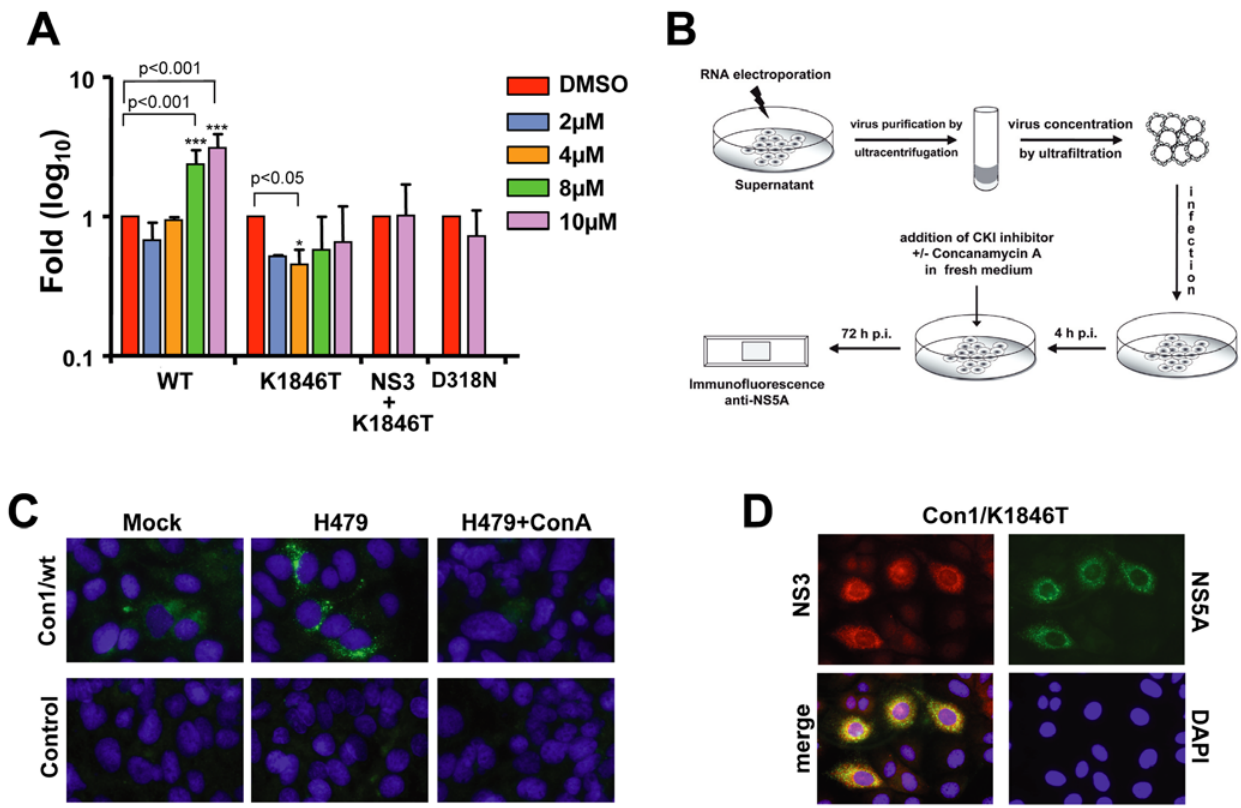
Figure 6. Invitro infectivity of Con1/wt particles released from transfected Huh7.5 cells. (A) Enhancement of HCV RNA replication by kinase inhibitor H479. Subgenomic Con1 luciferase replicons were transfected into Huh7.5 cells that were seeded into medium containing H479 at concentrations specified in the right. Cell lysates were prepared at 4 h and 48 h after transfection and luciferase activities were determined. The replication defective replicon Con1/D318N served as negative control. Cells treated with DMSO only were used as reference. For each construct, values were normalized to the luciferase activity of the respective DMSO control in order to determine the fold induction or reduction of replication. Data (mean 6 S.D.; n=3) were analyzed using two-way ANOVA test. (B) Experimental approach used to detect in vitro infectivity of Con1 virus. (C) Immunofluorescence analysis of Huh7.5 cells 72 h after inoculation with supernatant from cells transfected with the Con1/wt genome (upper panels) or mock transfected cells (lower panels). Cells were treated either with DMSO only (Mock; left panels), or with H479 (middle panels) or with H479 and ConcanamycinA (right panels) as specified in panel (B). Cells were fixed 72 h after inoculation and NS5A was detected by immunofluorescence microscopy. (D) Detection of NS3 and NS5A expression in Huh7.5 cells inoculated with cell-free concentrated supernatant containing Con1/K1846T particles. Cells were fixed 48 h after inoculation and processed for indirect immunofluorescence. Nuclei were counterstained with DAPI.